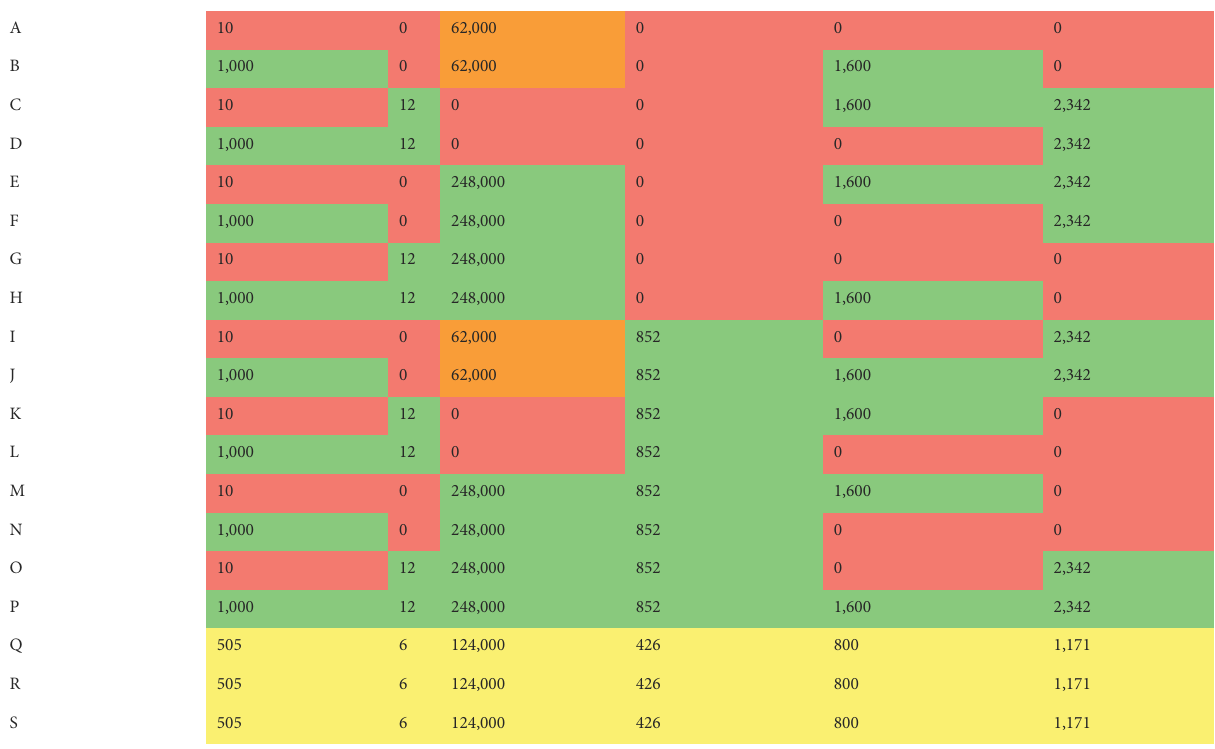
TABLE 2 Chemical composition of the 19 contact solutions made up for the fractional factorial experiment. Red = “ low ” value of variable. Green = “ high ” value of variable. Yellow = centrepoint value of variable. Orange = non-ideal concentration, due to essential addition to create